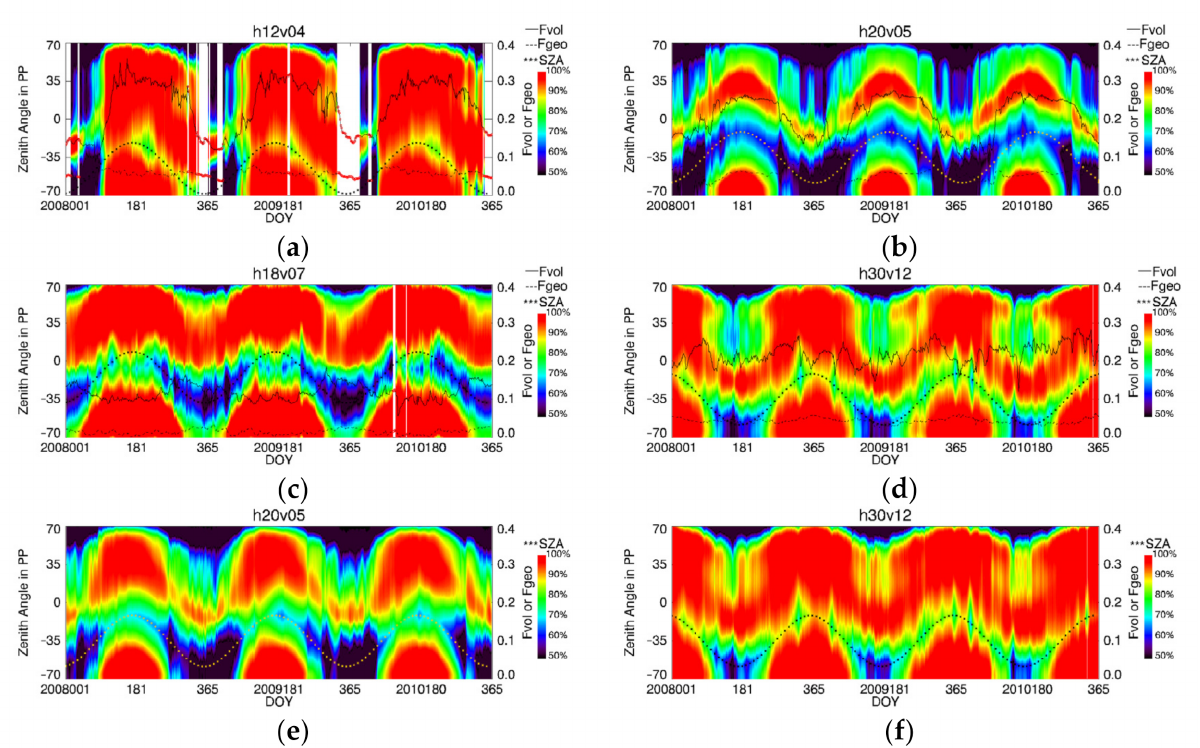
Figure 13. The distribution of F and P 0.02 in PP for the four tiles: ( a – d ) the results of the four tiles based on F ; ( e , f ) based on F L for h20v05 and F N for h30v12. The x-axis is the time, the right y-axis represents the value of the model parameter, and the left y-axis refers to the viewing zenith angle in PP. Different colors represent the values of P 0.02 . The dotted line refers to the solar zenith angle, the solid and dashed lines represent F vol and F geo , and the red circles represent that F is based on insufficient